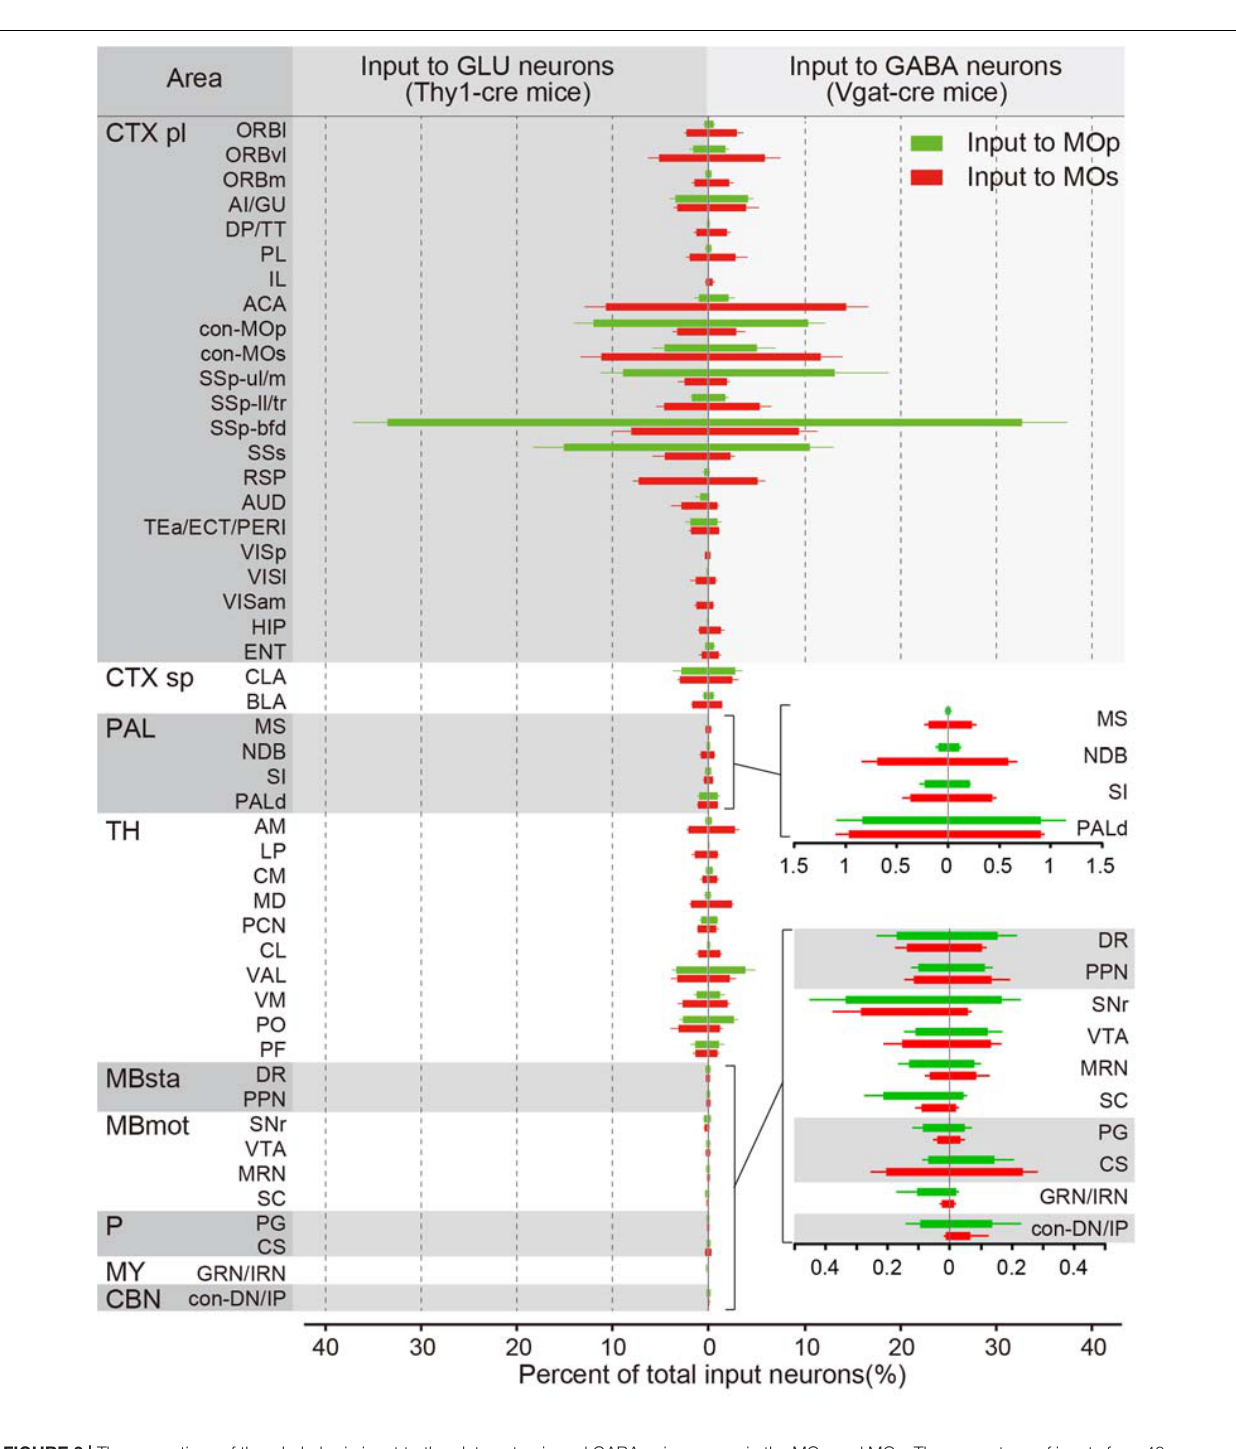
Frontiers in Neuroanatomy |